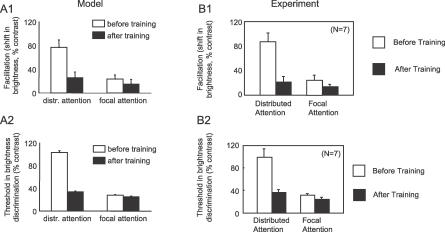
Summary of the Learning Performance for the Model (A) and the Experiment (B)(A) Unsupervised perceptual learning during distributed attention reduces the brightness facilitation (i.e., the decision bias, A1 left) and the discrimination threshold (A2 left) in the model. Focal attention by itself reduces facilitation (A1 right) and threshold (A2 right) before learning, but these quantities are only marginally reduced by the perceptual training.(B) Corresponding experimental data showing the close fit by the model. The figures are adapted from [1]. The number of stimulus presentations and trials in the model correspond to numbers in the experiment (see Materials and Methods). In the model, the average data from the first week (before learning) and the 20th week (after learning) was gathered from seven different runs. In the experiment, data was pooled from five human and two monkey subjects.